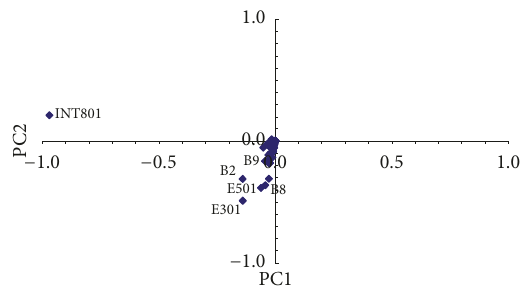
Figure 8: PCA of the total samples by PNEC and sampling points at the highest environmental risk.